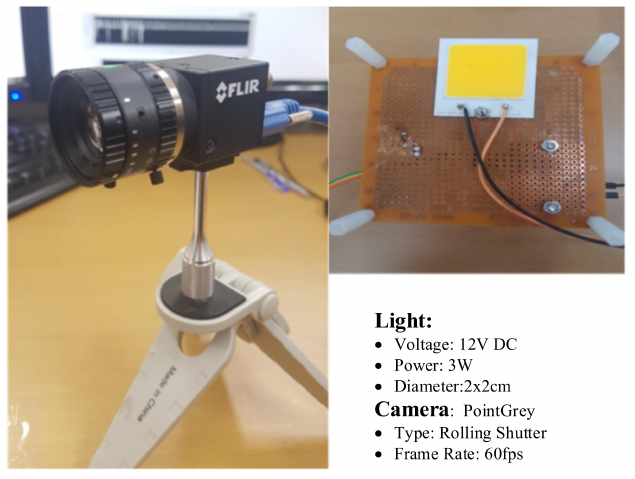
Figure 5. Device for SNR measurement.